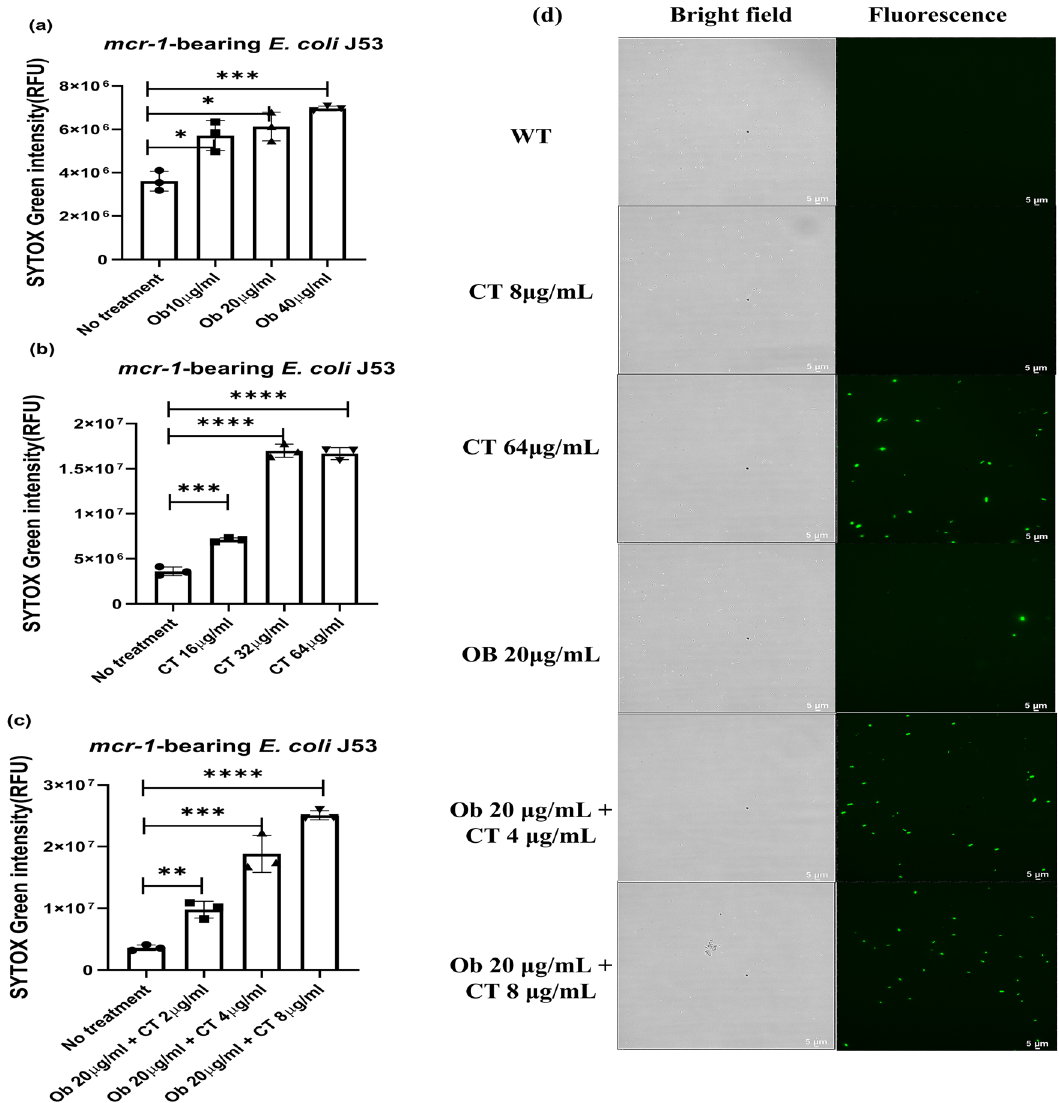
Fig. 6 Ob enhances the membrane-permeabilizing effect of colistin on colistin-resistant E. coli . The bacterial membrane permeability of mcr-1 -bearing E. coli J53 treated with a Ob, b colistin, and c a combination of both agents was determined by using SYTOX green. d Microscopic images of bacterial cell membrane permeability of mcr-1 -bearing E. coli J53 treated with Ob, colistin, and a combination of both agents. Statistical analysis was performed using unpaired two-tailed student t -test. Data are mean ± SEM for n = 3 biologically independent experiment. * p < 0.05, ** p < 0.005, *** p < 0.0005, **** p <